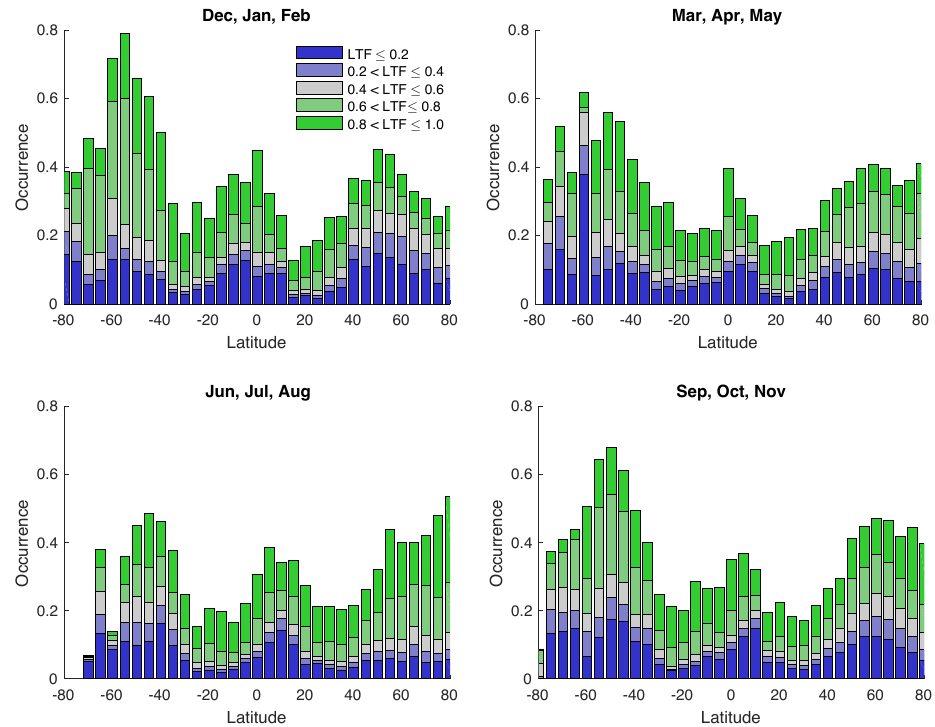
Figure 6. Zonal average cloud phase, partitioned by season, for all 10 years of observations. Sampling is nonuniform across latitudes; Sect. 3 quantifies uncertainty due to finite sample